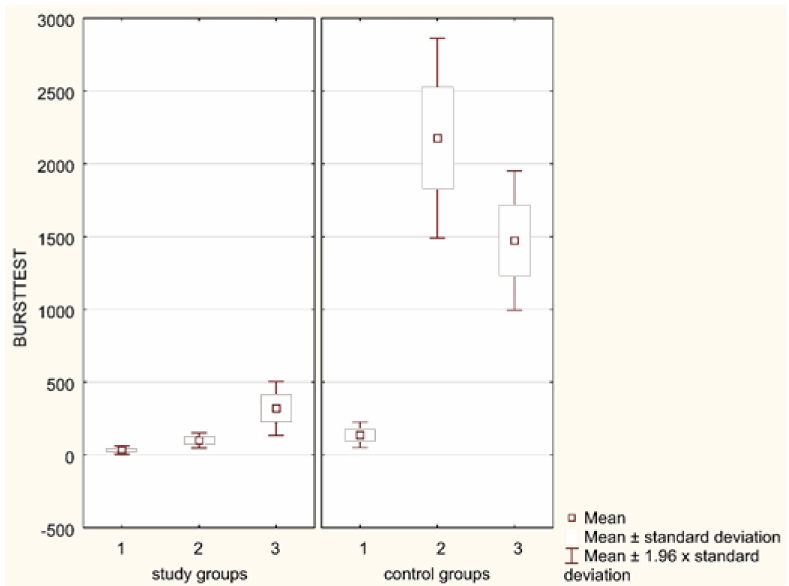
Figure 3. Neutrophil respiratory burst after PMA stimulation (in the studied children with sepsis (Group 1), burns (Group 2), and bone fractures (Group 3) at the time of diagnosis and in the control